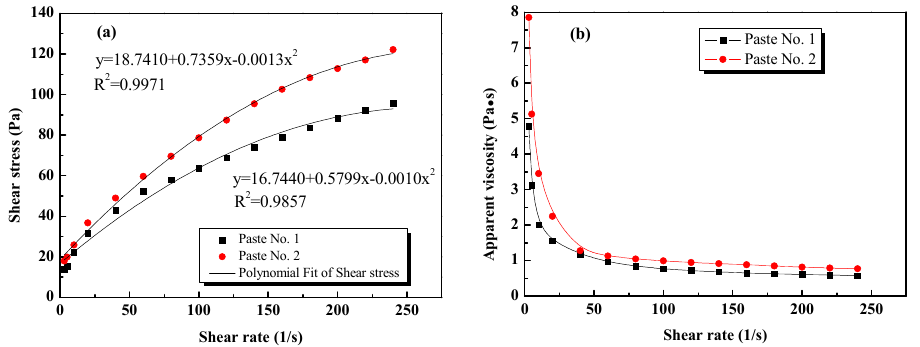
Figure 4. Rheological parameters of GO cement pastes: ( a ) shear rate vs. shear stress; ( b ) shear rate vs. apparent viscosity.